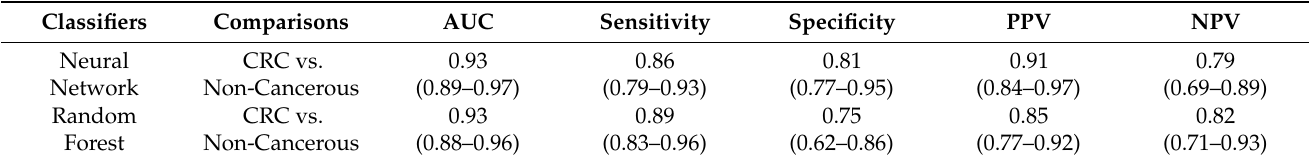
Figure 6. Output from the GC-TOF-MS to a late CRC urine sample with each peak representing the abundance of the chemicals at retention time. Table 4. Statistical Results for GC-TOF-MS with 95% confidence intervals in brackets.